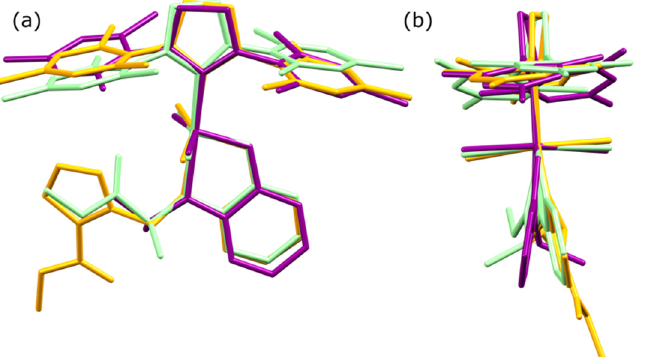
Figure 4. Front view ( a ) and side view ( b ) of molecular overlay for Hoveyda–Grubbs (violet), Ru10 ′ (light green) and Ru16 (orange) catalysts. Molecules represented by sticks, and hydrogen atom omitted for clarity.